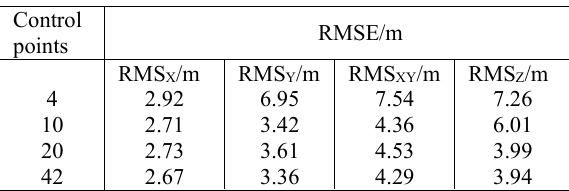
Table 5. Stereo positioning results after linear model